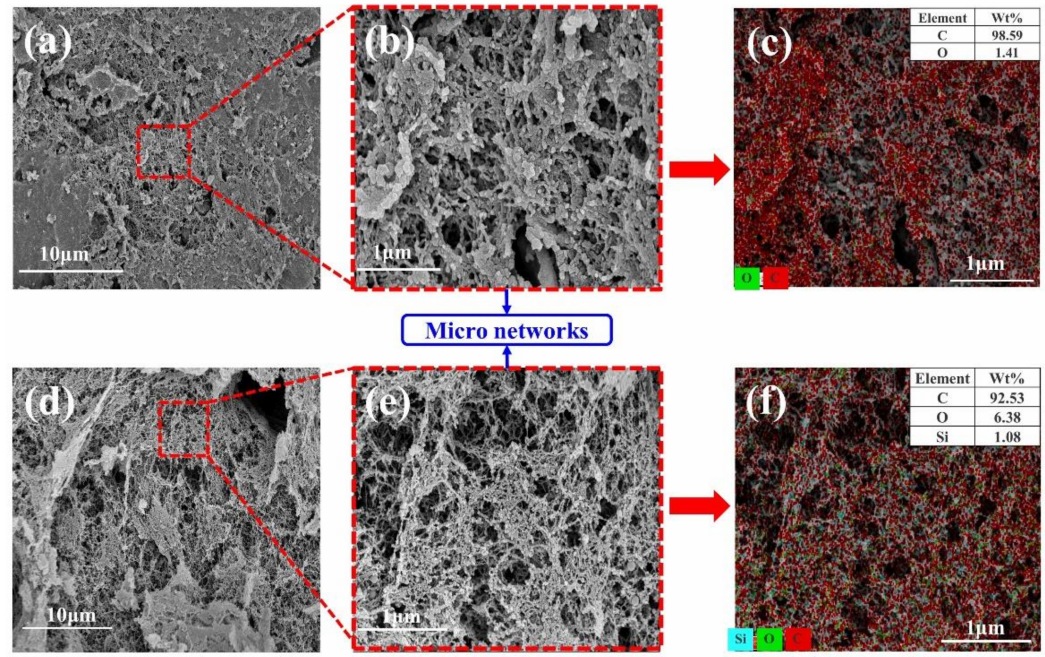
Figure 4. Analysis of micro networks in the char layer: NS-C-3 ( a – c ) and S-C-3 ( d – f